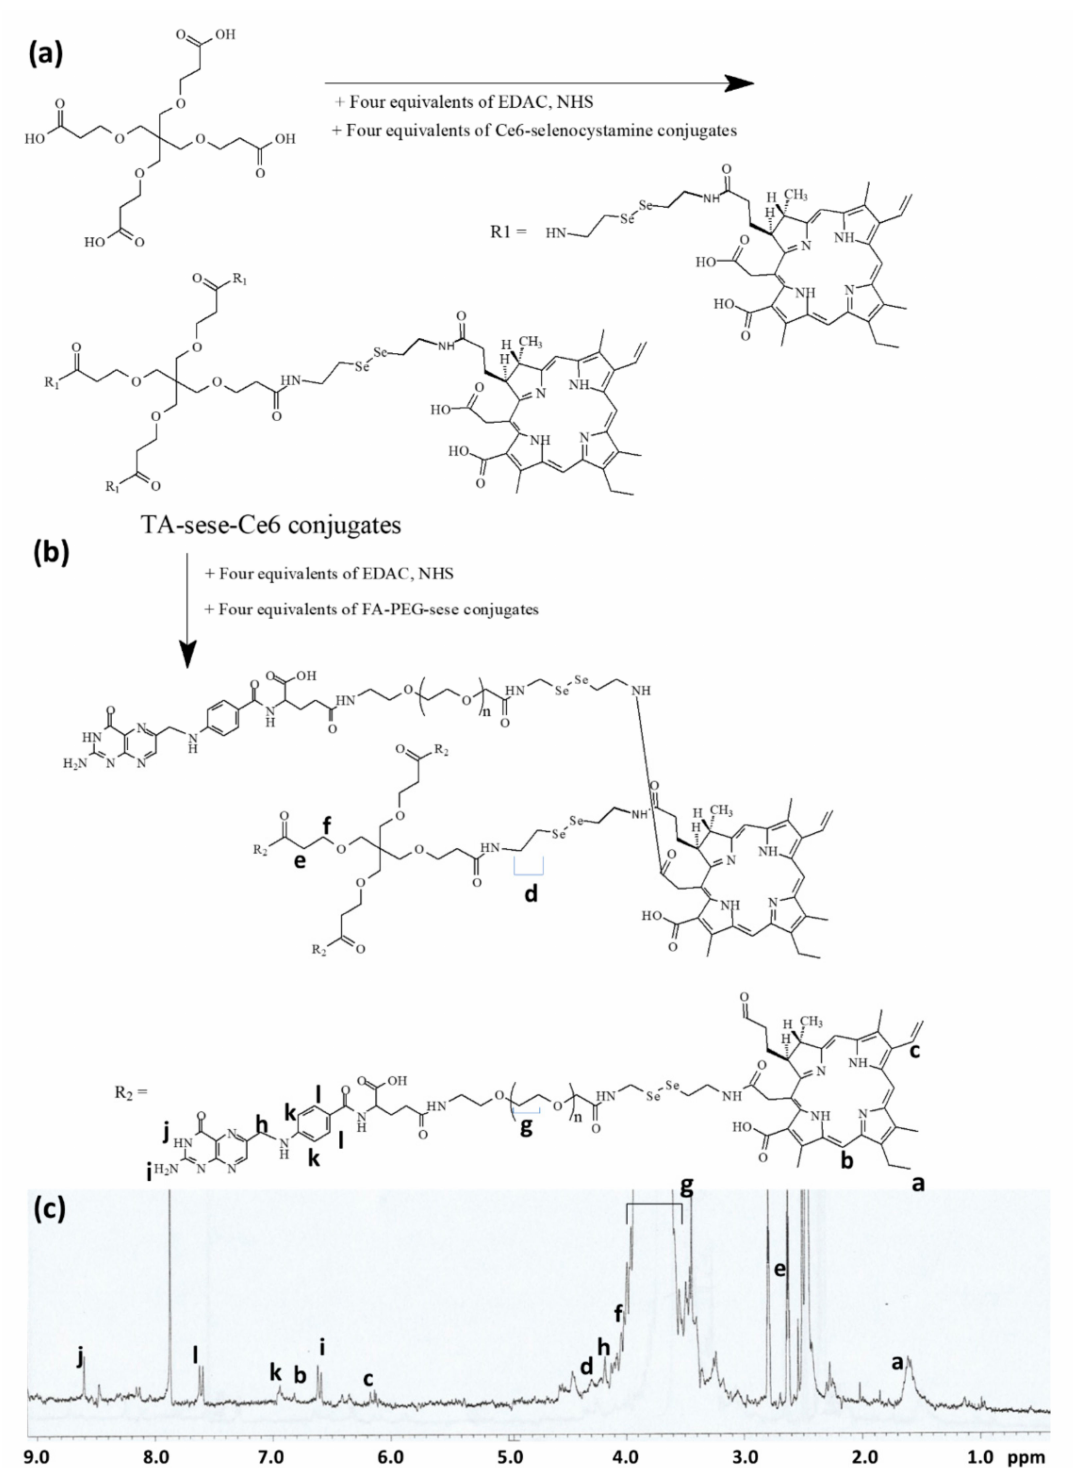
Figure 1. Synthesis scheme and 1 H NMR spectra of FAPEGtaCe6 conjugates. Synthesis scheme of TA- sese-Ce6 tetramer ( a ) and FAPEGtaCe6 conjugates ( b ). ( c ) 1 H NMR spectra of FAPEGtaCe6